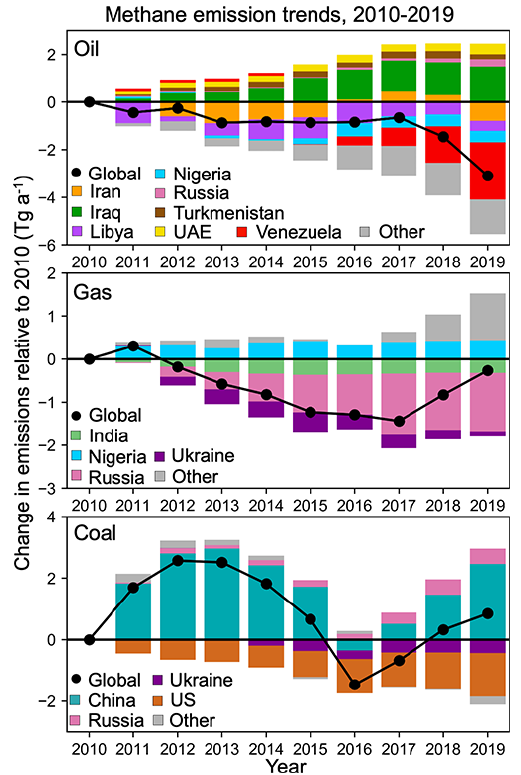
Figure 4. Global methane emission trends for the oil, gas, and coal sectors from 2010 to 2019 in GFEI v2, expressed relative to 2010. Trends for individual countries contributing the most to the global trends are also shown. US – United States; UAE – United Arab